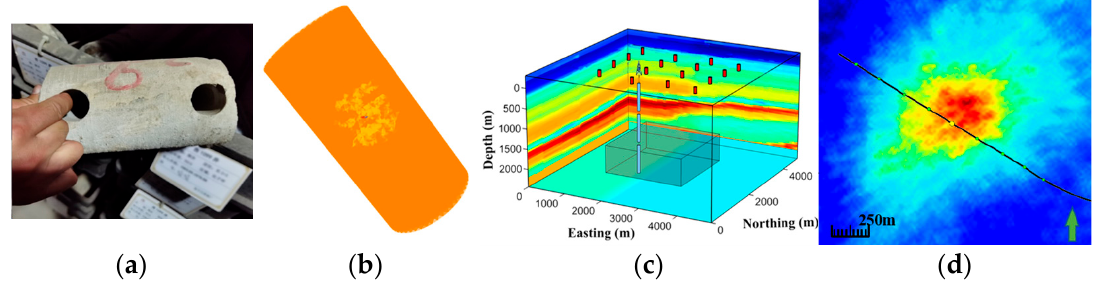
Figure 13. CCUS geological and geophysical comprehensive monitoring technology. ( a ) Reser- voir rock experiment. ( b ) Numerical simulation. ( c ) Combined well–ground monitoring system. ( d ) Intelligent processing interpretation platform .